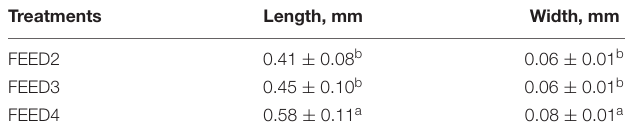
TABLE 2 | Fecal pellet sizes for Calanus helgolandicus females obtained after 24 h from different diet treatments (Mean ± Standard Deviation SD , low-case letters denote significant variable differences between means of different treatments using Duncan’s Multiple Range test, P < 0.05).